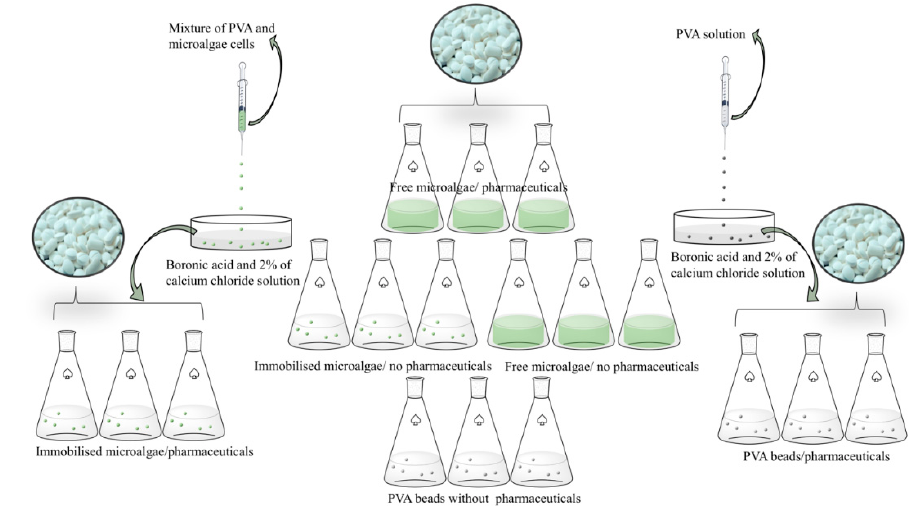
Figure 1. Schematic representation of the procedure used in the bioremediation experiments.